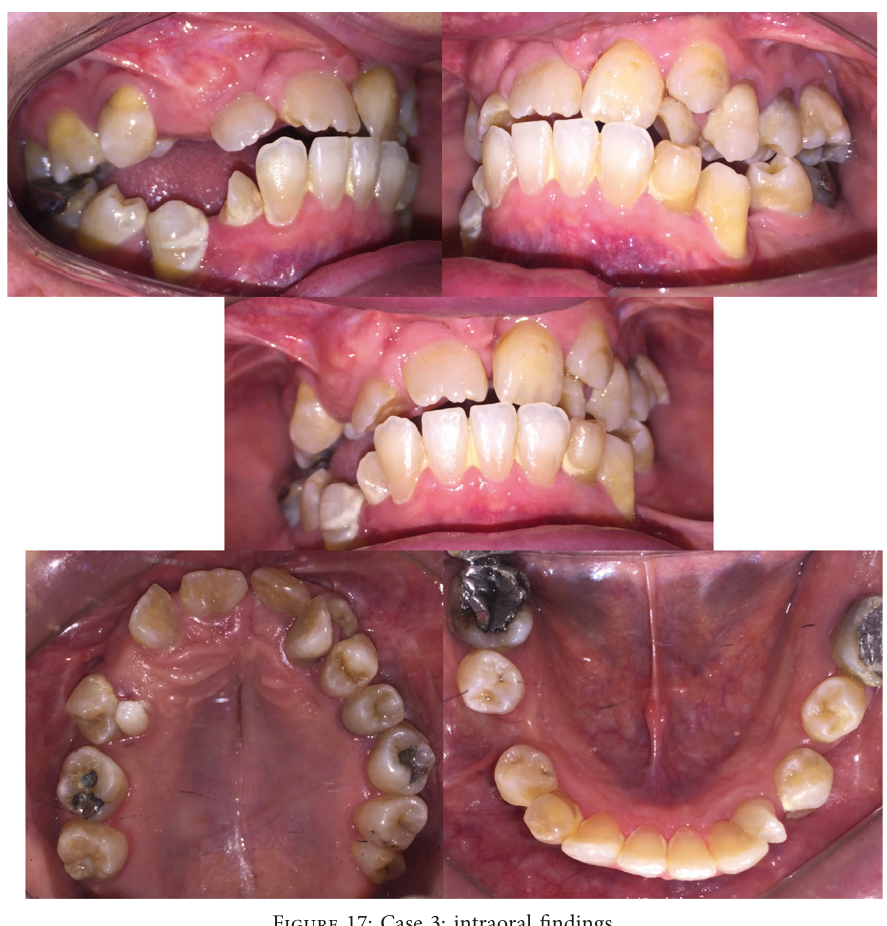
Figure 17: Case 3: intraoral findings.